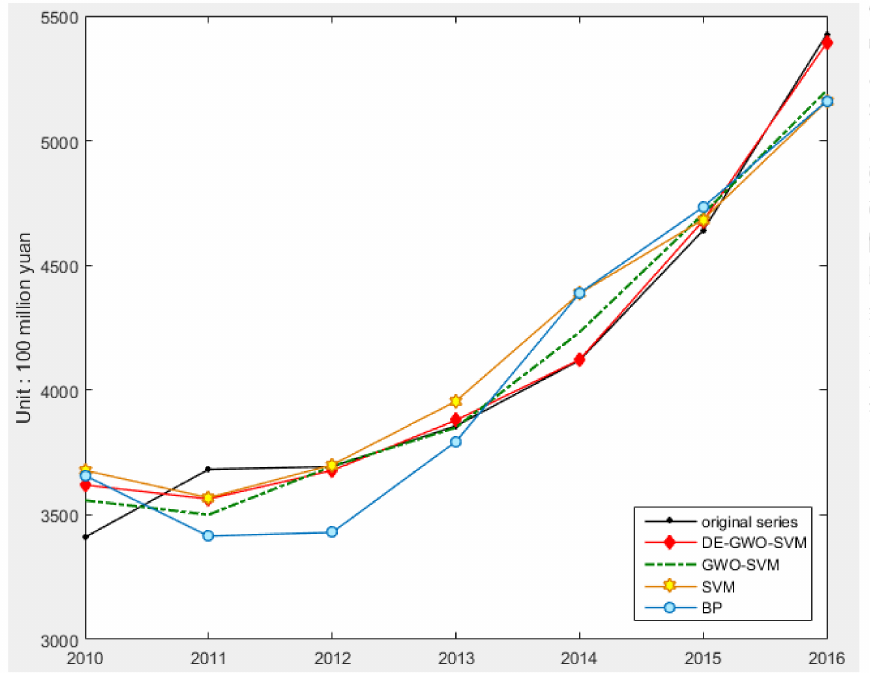
Figure 5. Forecasting results